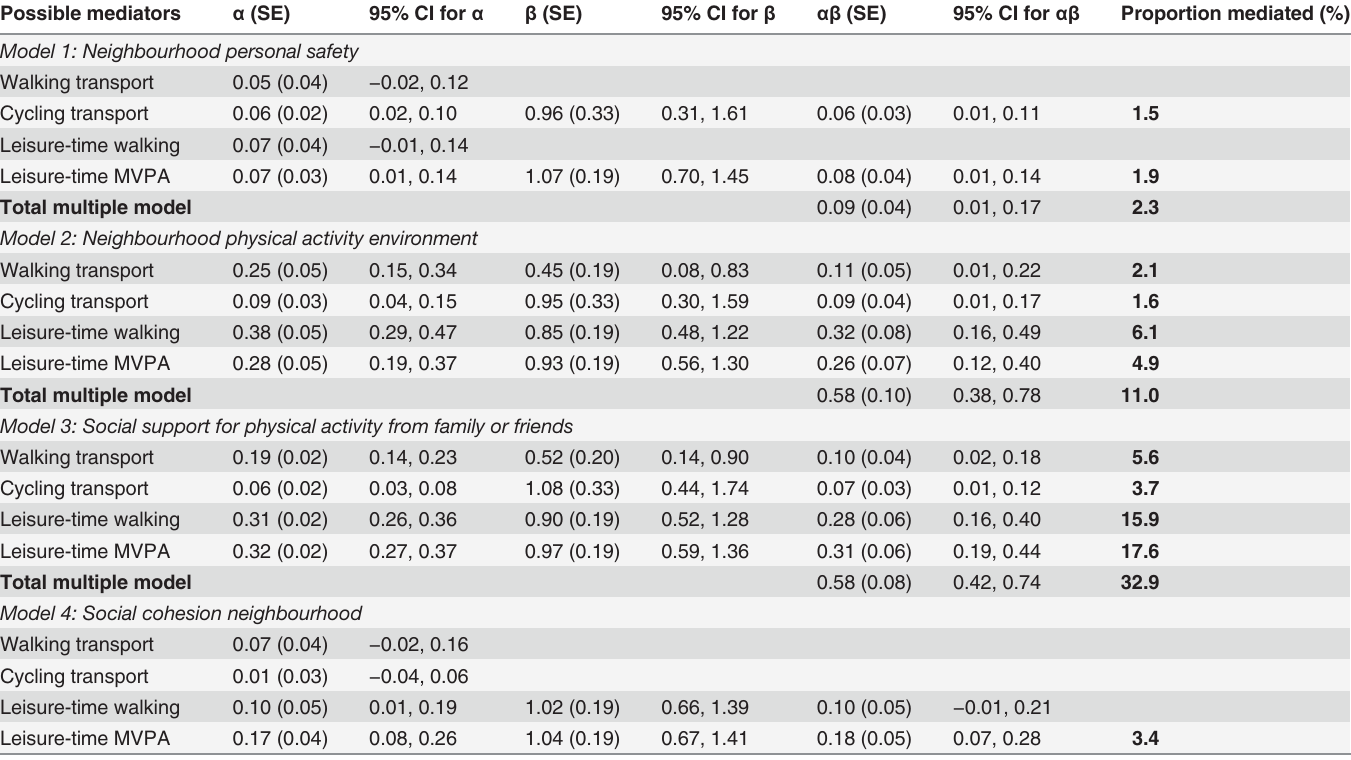
Table 3. Regression analyses for possible mediators of the associations between physical/social environmental perceptions and mental health- related quality of life. Possible mediators